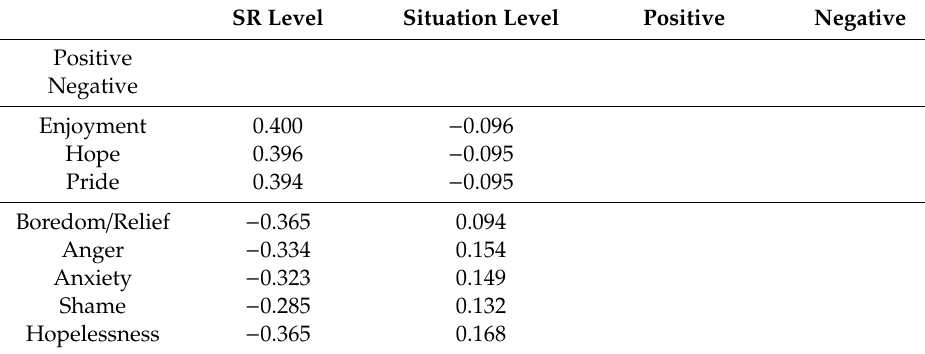
Table 4. Standardized linear indirect e ff